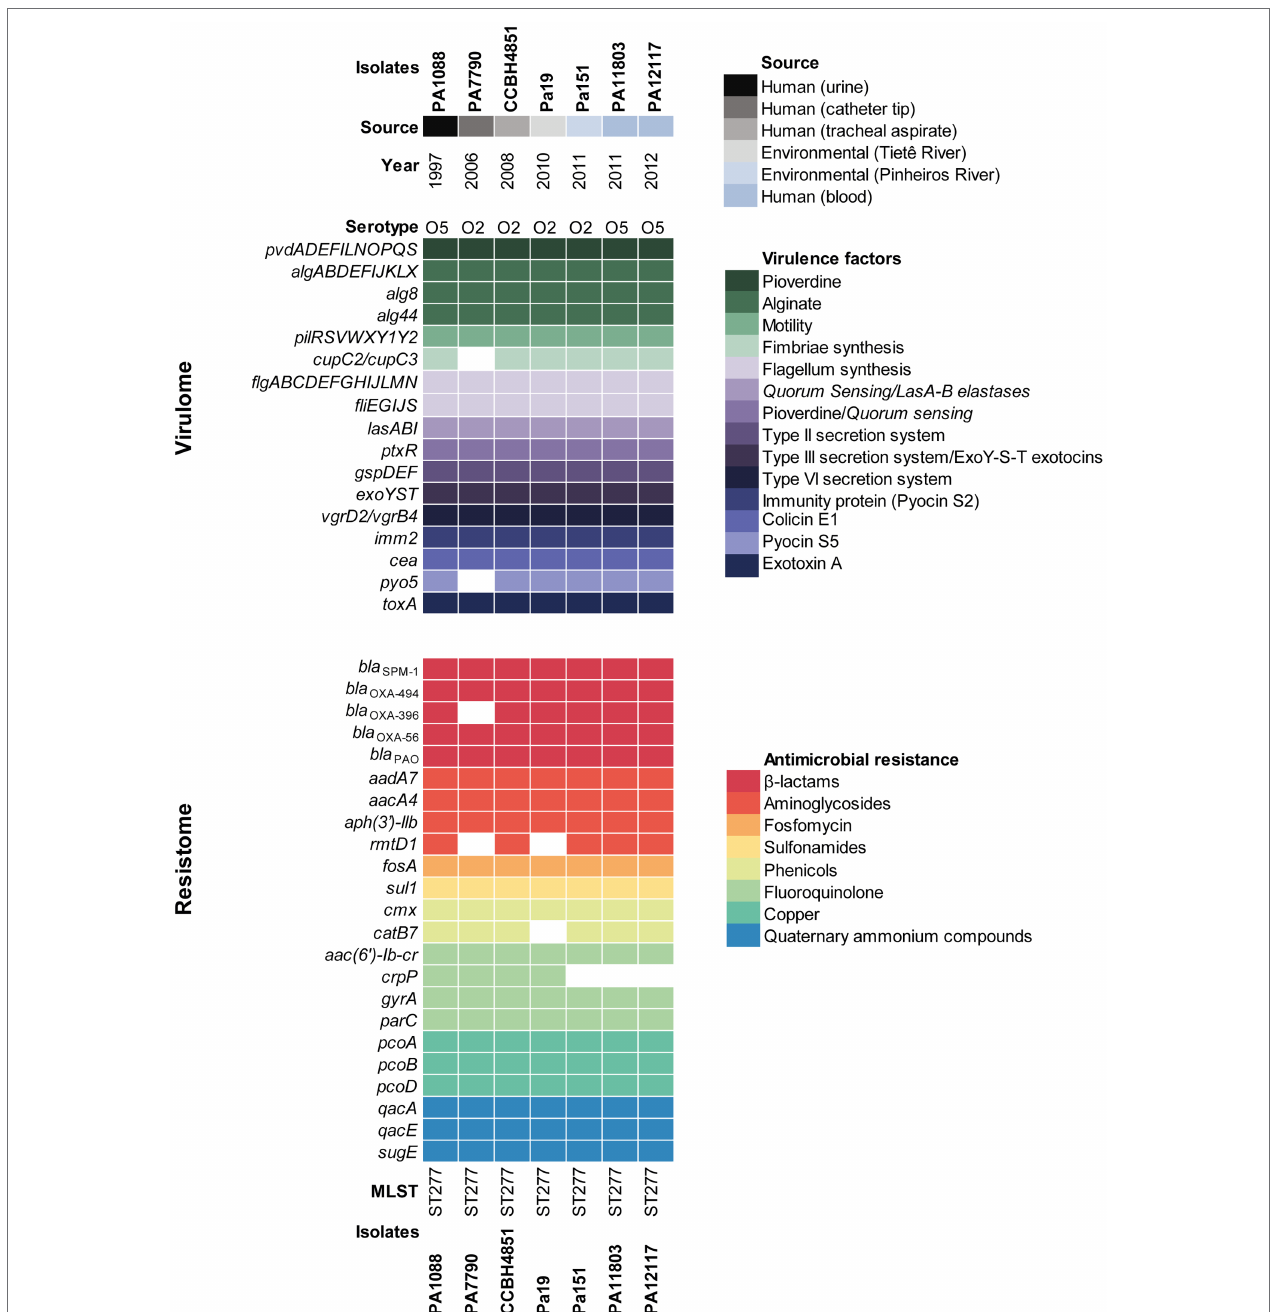
FIGURE 2 | Heatmap showing the distribution of virulence and resistance genes in environmental and clinical SPM-1-positive P. aeruginosa strains of ST277 clone. Virulence genes are listed along with their functions and demarcated by colored squares. Resistome is demarcated by colored squares under genes names grouped by their antimicrobial resistance classes. Pseudomonas aeruginosa strains are indicated by colors displaying their source and year of